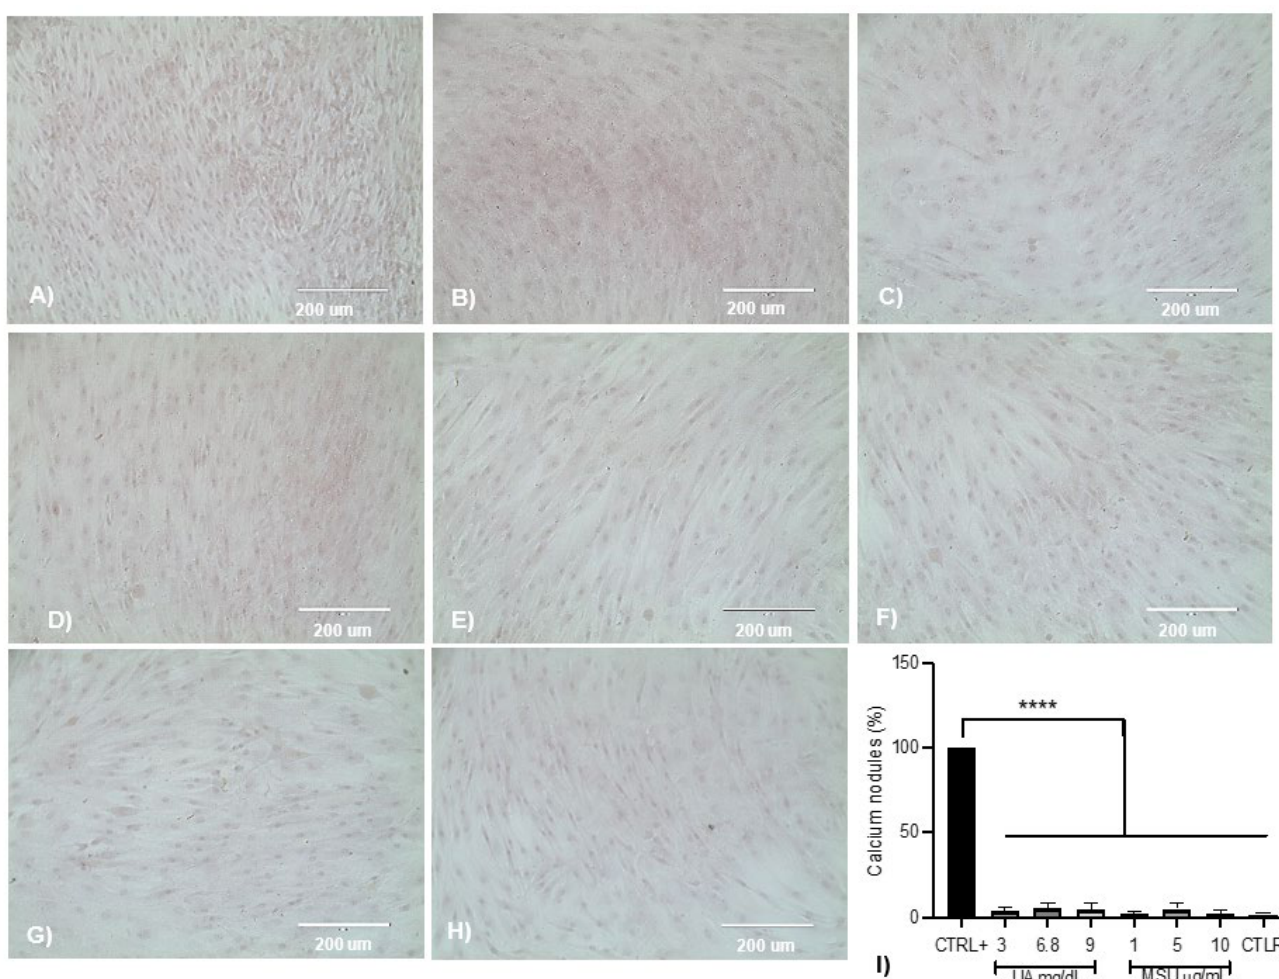
Figure 3. Effect of UA and MSU crystals on the formation of calcium nodules. ( A ) Osteogenic induction control, ( B ) 3 mg/dL UA, ( C ) 6.8 mg/dL UA, ( D ) 9 mg/dL UA, ( E ) 1 μg/mL MSU crystals, ( F ) 5 μg/mL MSU crystals, ( G ) 10 μg/mL MSU, and ( H ) control. Bright-field microscopy; cell culture with red-stained calcium nodules (20×), representative of independent experiments ( n = 6). The formation of calcium nodules was observed to be high in the positive control (osteogenic medium); in the cells cultured in media containing UA and MSU crystals, the effect was null, as was that in the control. ( I ) Alizarin red staining was quantified by removing the dye with isopropanol. The data represent the mean ± SD of independent experiments (**** p < 0.00001 vs. control +).